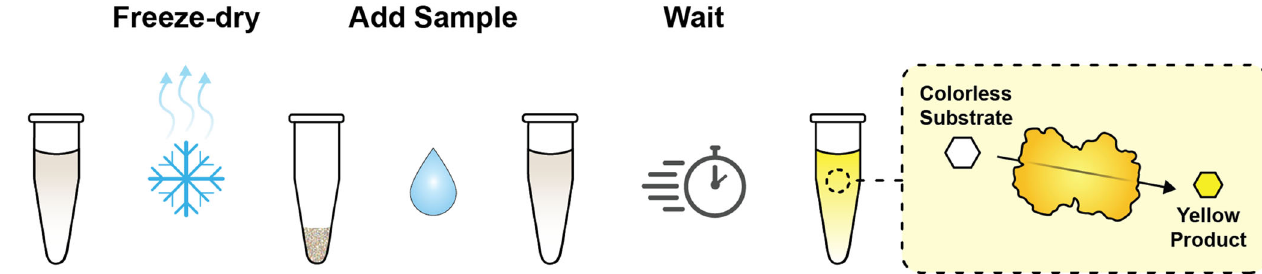
Fig. 1 Schematic representation of a fl uoride biosensor. A sensing reaction is prepared, freeze-dried, then rehydrated with a sample of interest. An enzymatic reaction occurs in the presence of fl uoride, which converts a colorless substrate in the reaction to a yellow